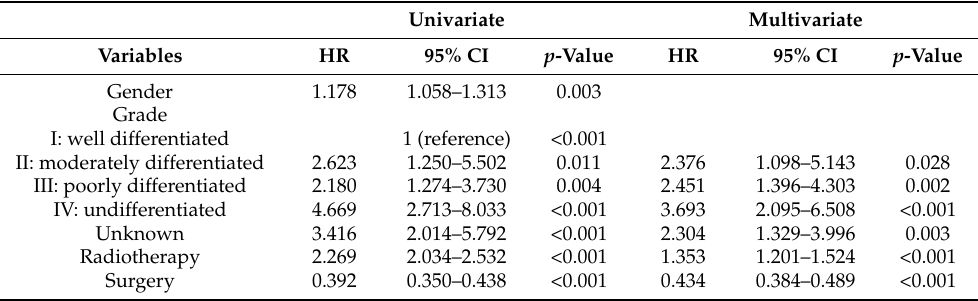
Table 3. Univariate and multivariate Cox regression analyses for predicting the mortality of the patients with